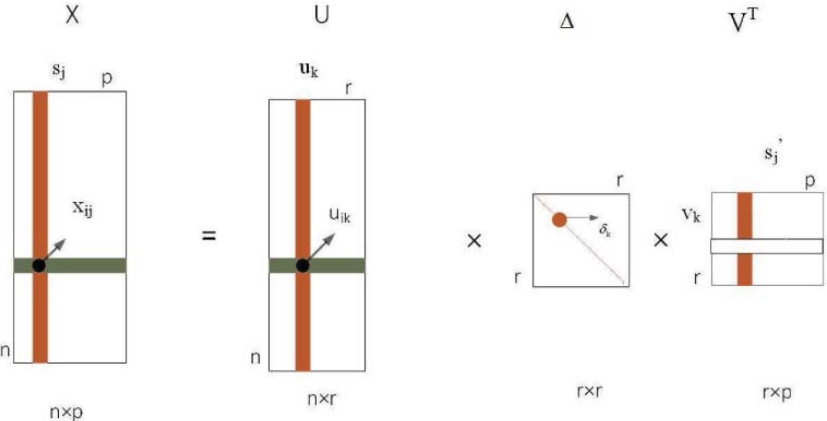
PMD . Matrix X is decomposed into two base matrices, Figure 3. Graphical description of Figure 3. Graphical description of PMD pc . Matrix X is decomposed into two base matrices, namely, U , pc V , and a diagonal matrix ∆ namely, U , V , and a diagonal matrix  . PMD pc